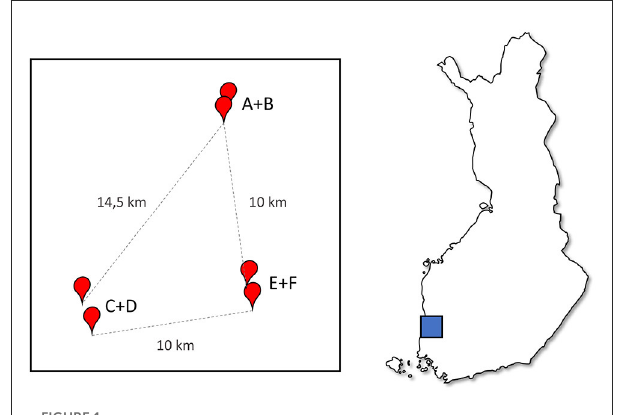
FIGURE1 A diagram of the apiary locations relative to each other, apiaries (A–F) marked with red points showing distances, and the location in Finland (map box size